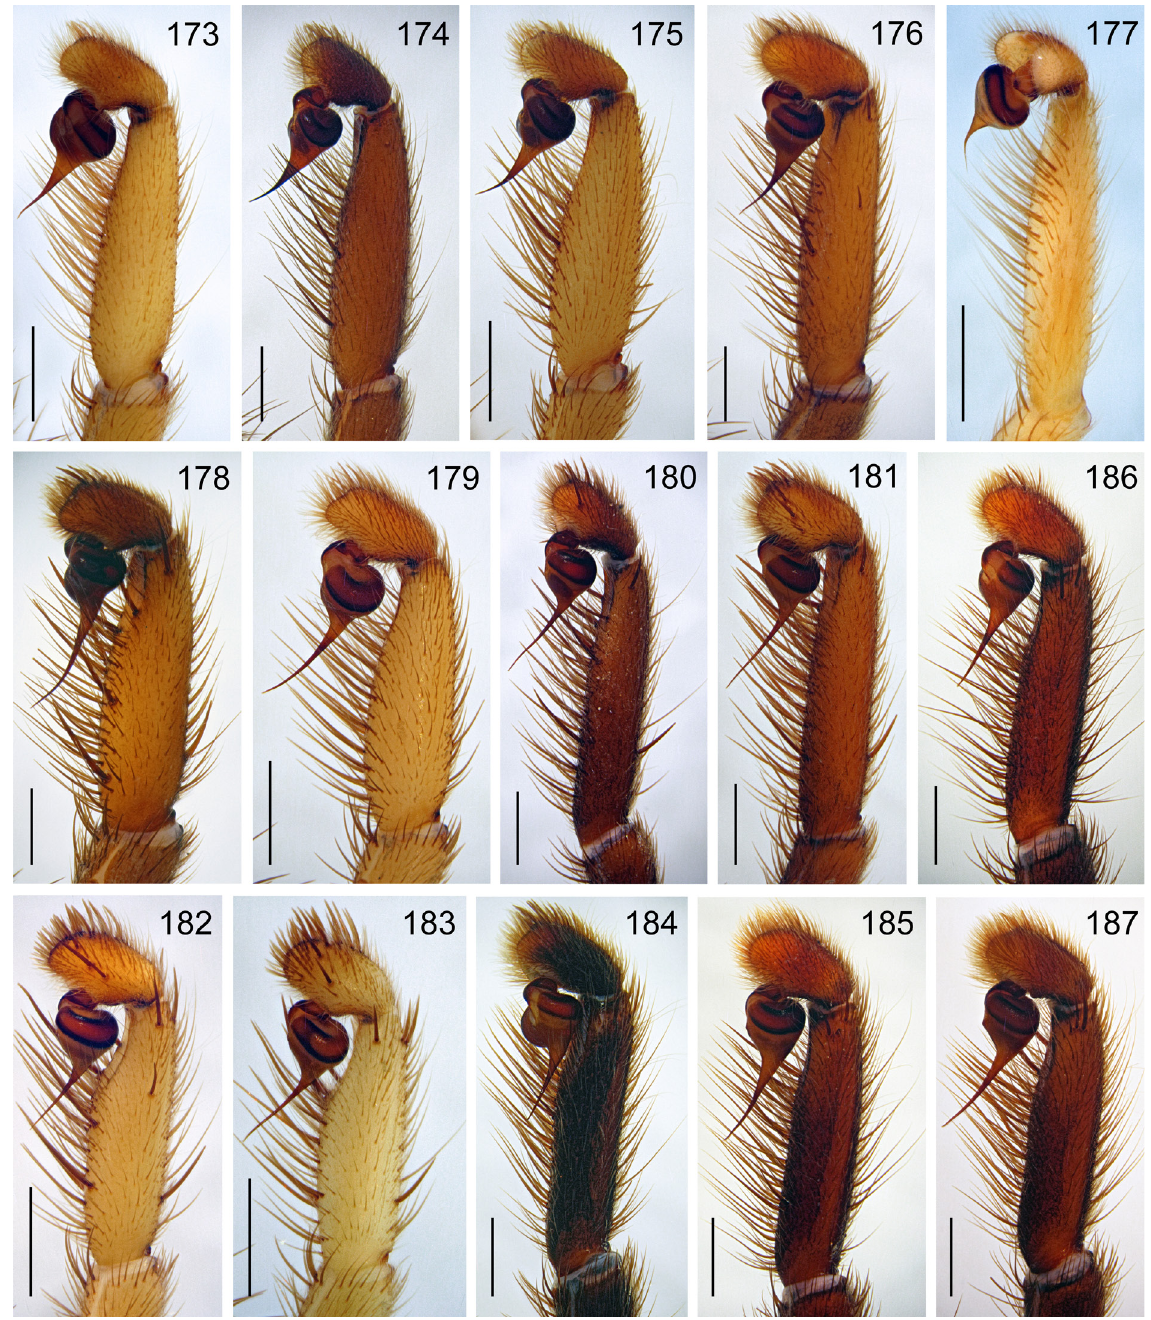
Figs 173–187. Anemesia spp., ♂♂, palpal tibia, cymbium and palpal organ, retrolateral views. 173 . A. birulai (Spassky, 1937) (holotype). 174 . A. koponeni Marusik, Zamani & Mirshamsi, 2014 (holotype). 175 . A. pococki sp. nov. (holotype). 176 . A. tubifex (Pocock, 1889) (Kalaimor). 177 . A. andreevae sp. nov. (holotype). 178 . A. oxiana sp. nov. (holotype). 179 . A. sogdiana sp. nov. (holotype). 180 . A. castanea sp. nov. (holotype). 181 . A. karatauvi (Andreeva, 1968) (Hojamaston). 182 . A. pallida sp. nov. (holotype). 183 . A. parvula sp. nov. (holotype). 184 . A. incana Zonstein, 2001 (holotype). 185 . A. infumata sp. nov. (holotype). 186–187 . A. infuscata sp. nov. (paratype from Sanglok Mts and holotype, respectively). Scale bars: 1.0